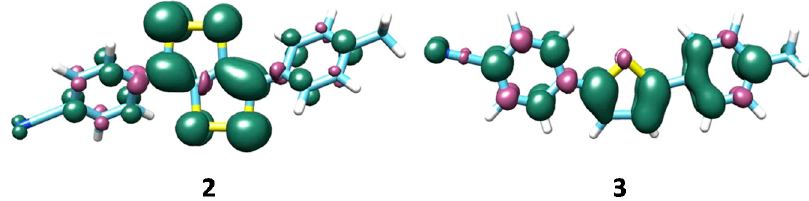
Figure 3. M06/6-31G* spin density contour plot for radical cations of compounds 2 and 3 .